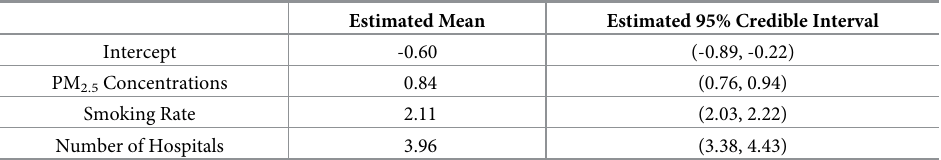
Table 4. Estimation results of the CG model for the hospital visit rate for respiratory diseases. The estimated mean and 95% credible intervals for different variables are